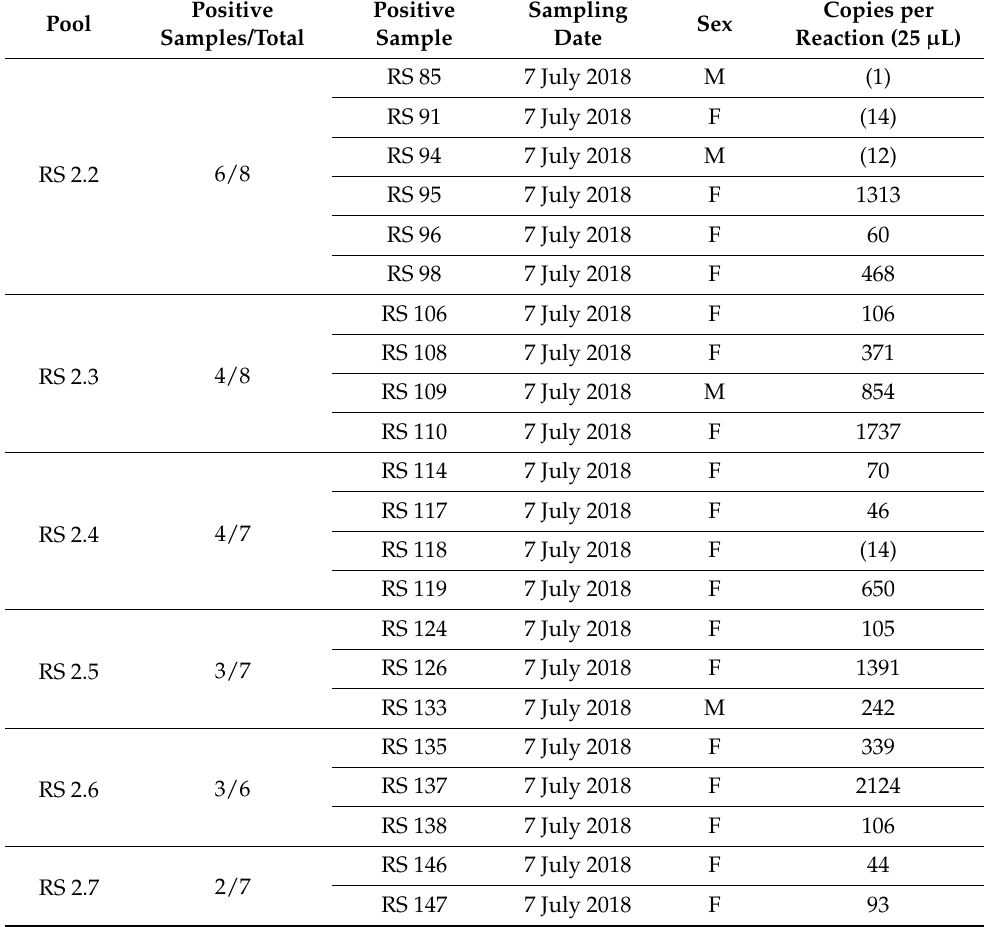
Table 4. Overview of positive results after screening of the rectal swab with the newly designed real-time RT-PCR assay for the detection of the novel batCoV/MinFul/2018/SriLanka; copy numbers of 15 and below are shown in